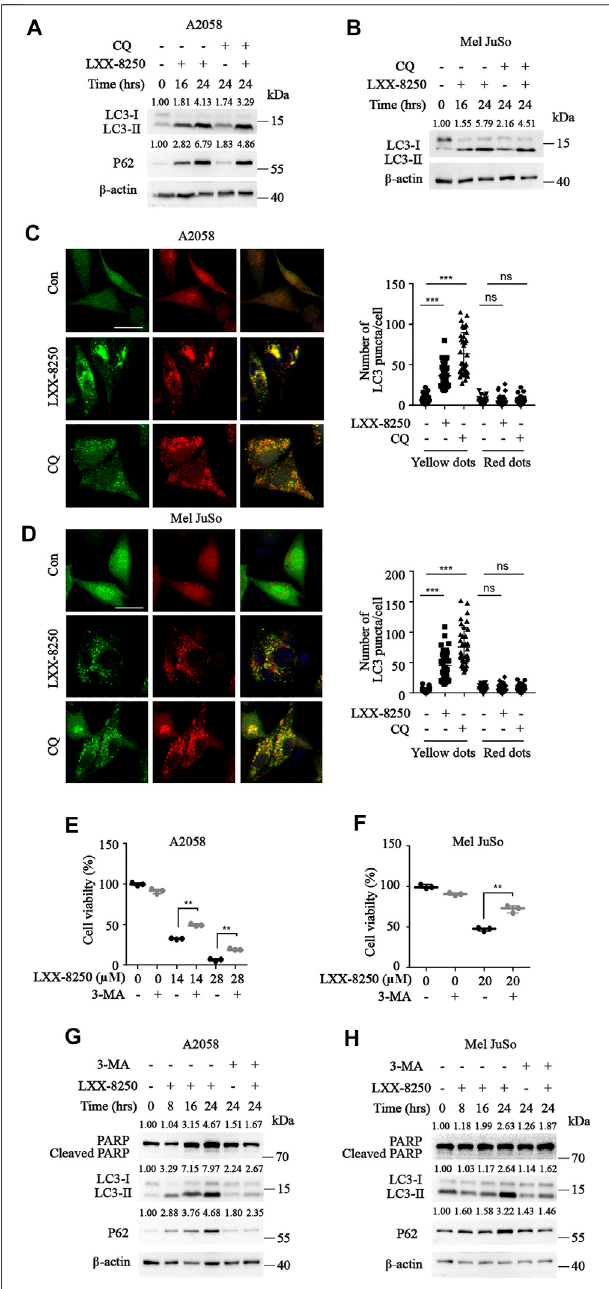
FIGURE 2 | Effects of LXX-8250 on autophagy. (A,B) Western blot analysis for the cells with the indicated treatment at the indicated time. LXX- 8250 14.6 µM, (A) ; 22.8 µM, (B) ; CQ, 10 μ M. (C,D) The indicated cells transfected with mRFP-EGFP-LC3 were treated with LXX-8250 14.6 µM, (C) ;22.8 µM, (D) orCQ(10 μ M)for24 h.LC3punctawereshownin representative micrographs with a scale bar of 25 μ m. Thirty-six cells of each treatment were counted for puncta, and the numbers (autophagosomes, yellow dots; autolysosome, red dots) per cell were plotted. (E,F) Cell viability assays in the cells treated with the indicated concentration of LXX-8250 together with or without 3-MA (2 mM) for 48 h (G,H) Western blot analysis for the cells treated with LXX-8250 14.6 μ M, (G) ; 22.8 µM, (H) for the indicated times together with or without 3-MA (2 mM). The quanti fi cation results of